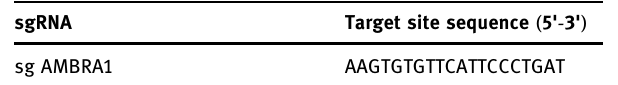
Table 2: Sequences of the sgRNA for